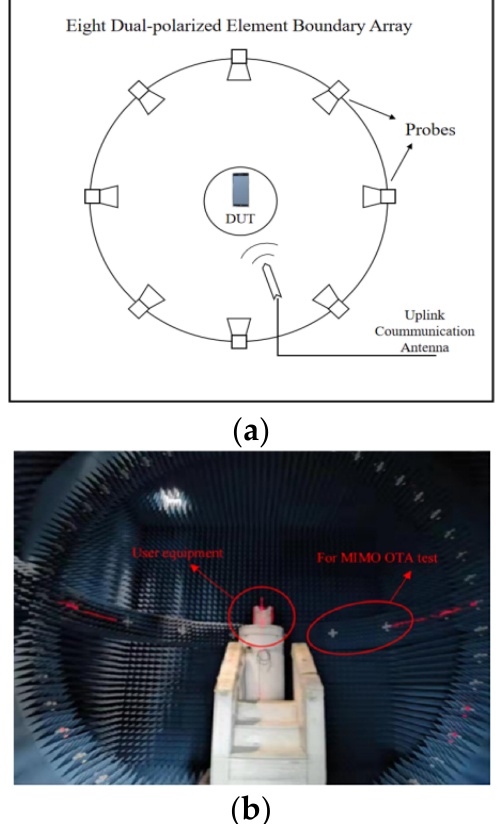
Figure 1. The system configuration ( a ) and measurement environment ( b ) of MPAC with multiple channel emulators and output amplifiers. Table 2. A summarization of the MIMO OTA testing setup.